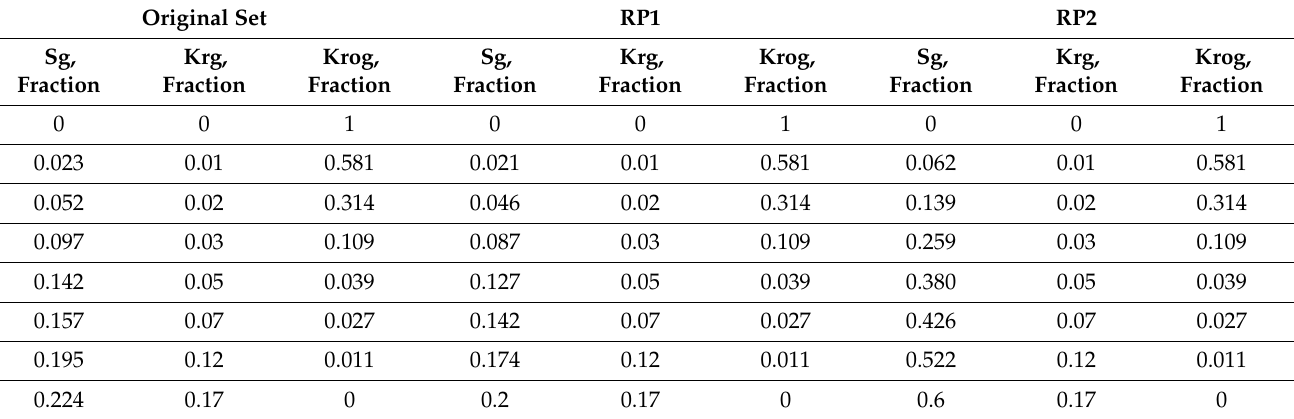
Table 4. Relative permeability curve sets.